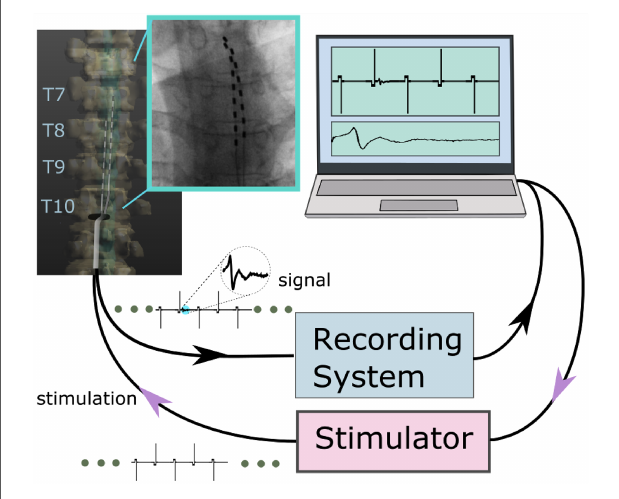
FIGURE 1 An overview of the stim-record system (ATLAS) connected to the externalized epidural leads implanted in a participant. The ATLAS Stim headbox delivered biphasic interleaved waveforms to two electrodes. The recording system recorded from all 16 channels.